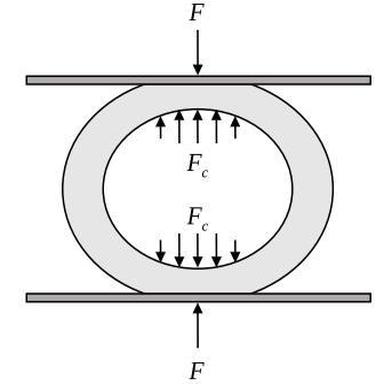
The schematic of forces being executed on the shell of a capsule.